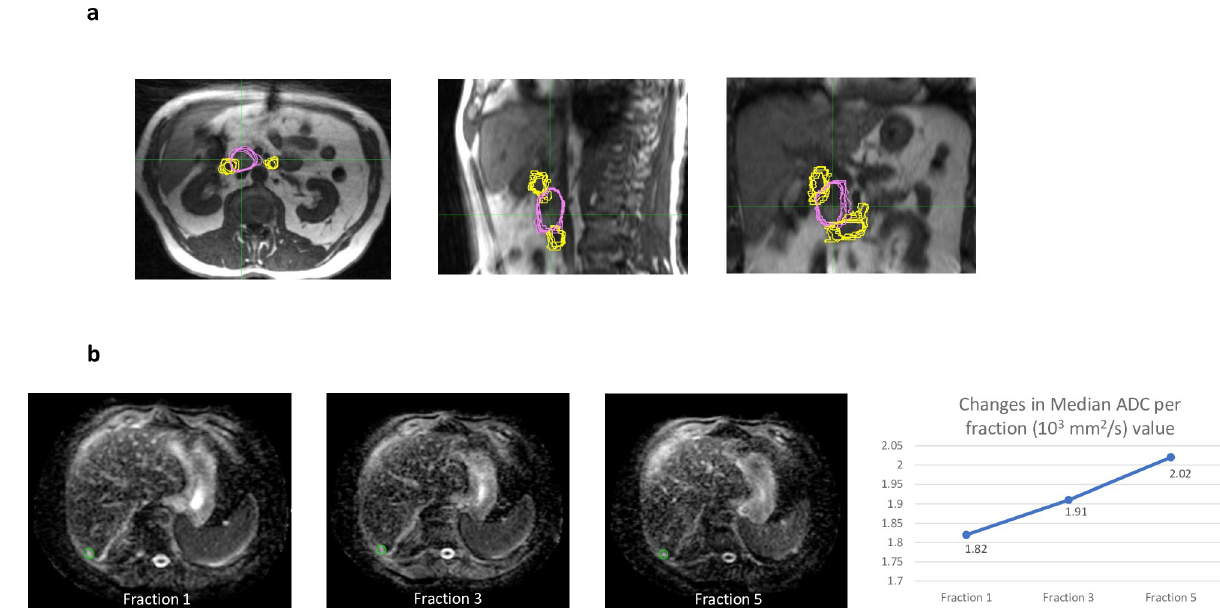
Fig 3. a. Aggregate contours for pancreatic ATS case illustrating daily small bowel and pancreatic CTV position differences, CTV (pink), small bowel (yellow). b. ADC measured during treatment with radiation, with increase in median ADC value during SBRT.